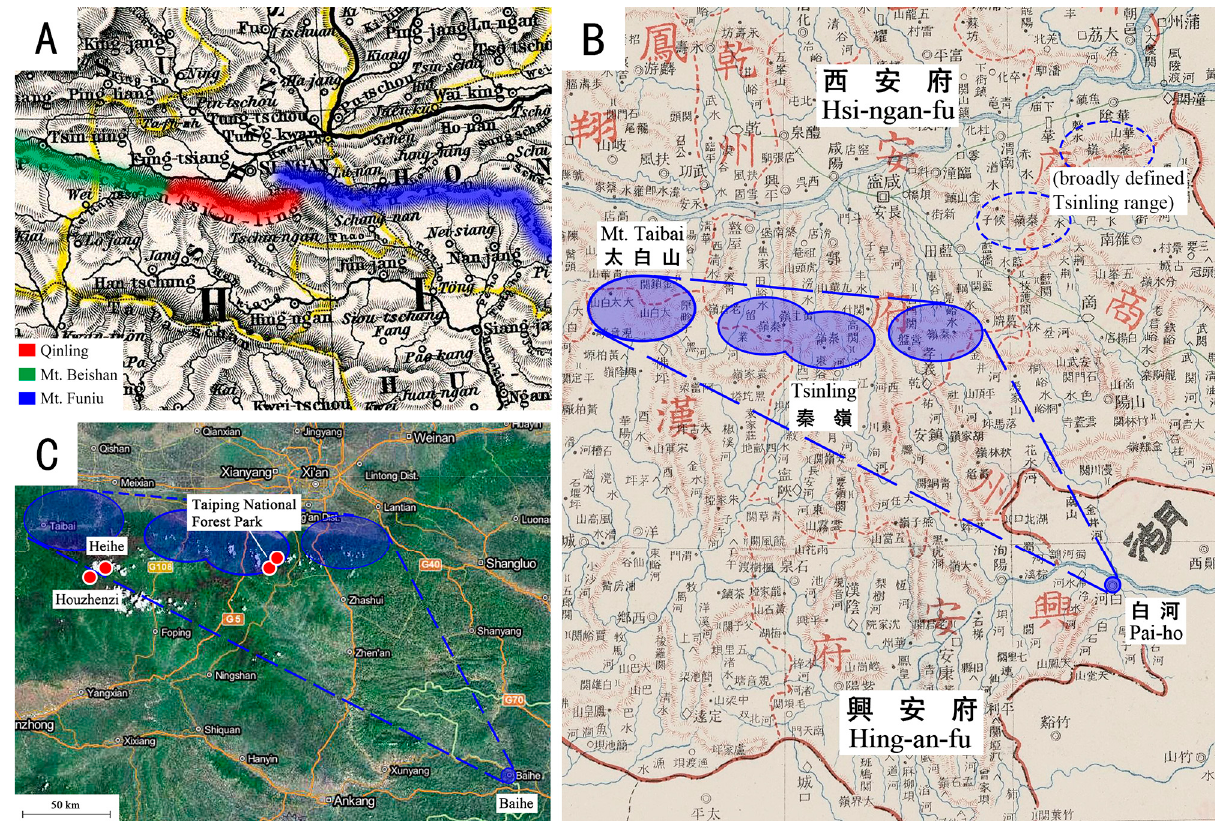
Figure 1. Qinling/Tsinling area with adjacent western and eastern mountains: ( A ) map modified at Stieler’s Hand‑atlas, “Chinesisches Reich”, 1891, provided by Wikipedia; ( B ) the possible range from the Qinling to Baihe/Pai‑ho is marked by blue dotted lines, Map of Shaanxi is modified by The Commercial Press [12]; ( C ) collecting localities of F. songi , map modified by (www.tianditu.gov.cn, accessed on 12 March